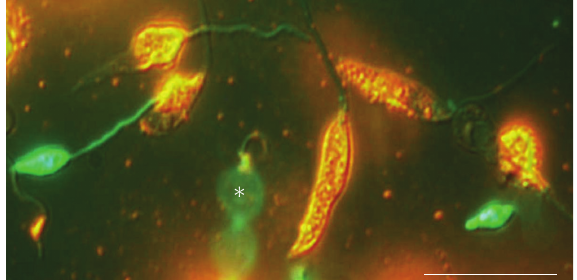
Figure 3: Histone toxicity to promastigotes. Promastigotes were incubated with purified histone for 30min and stained by the live/dead method. Dead promastigotes stained in yellow/orange and live promastigotes in green. Di ff erential interference contrast image merged with the fluorescence staining of the same cells. ( ∗ ) The beating of a live promastigote flagellum. Bars, 20 μ